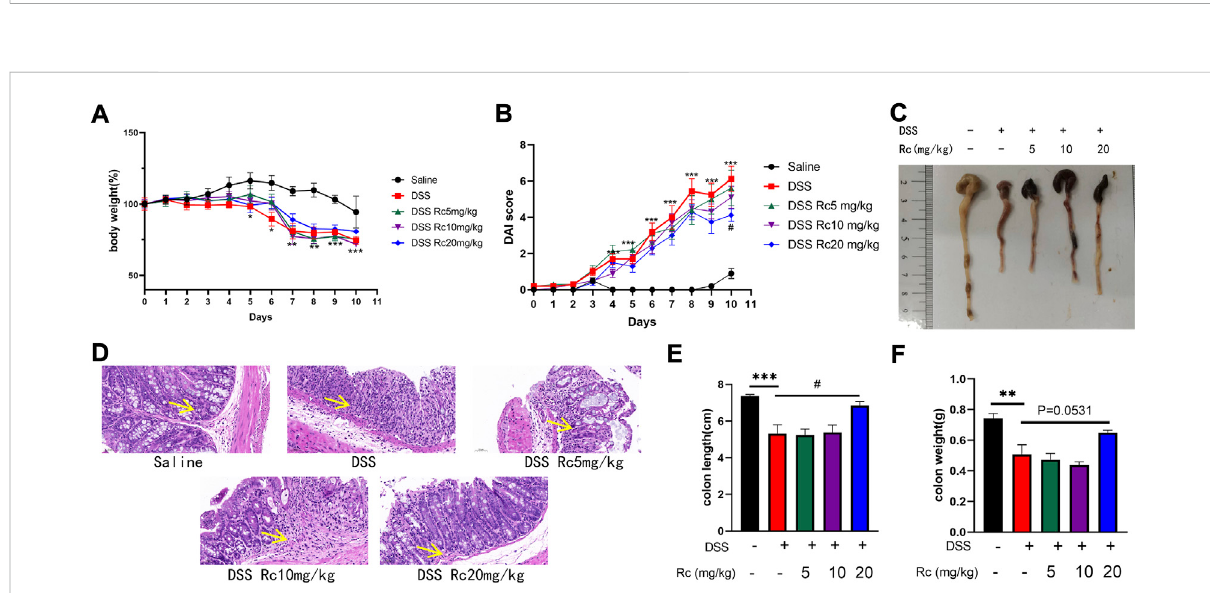
FIGURE 2 Rc ameliorated DSS-induced UC in mice. Body weight (A) changes and disease activity index (B) during the whole experiment; macroscopic observation of colon length (C) ; representative H&E-stained colon sections (magni fi cation: 200 ×) (D) ; the statistics of colon weight (E) and colon length (F) . Data are shown as the mean ± SEM ( n = 10). * p < 0.05, ** p < 0.01, *** p < 0.001 vs . the saline group; # p < 0.05 vs . the DSS